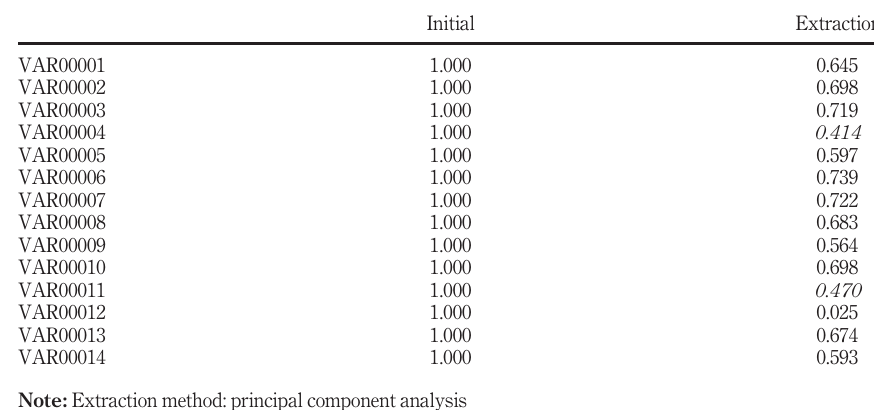
Table IV. SPSS output communality